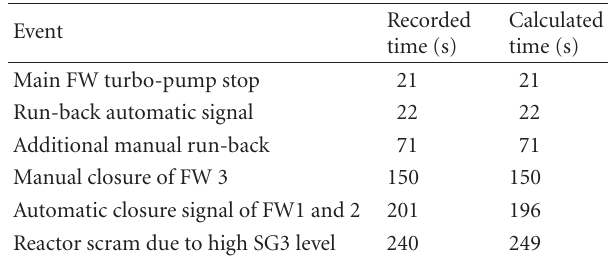
Table 2: Sequence of events for FW turbo-pump actual